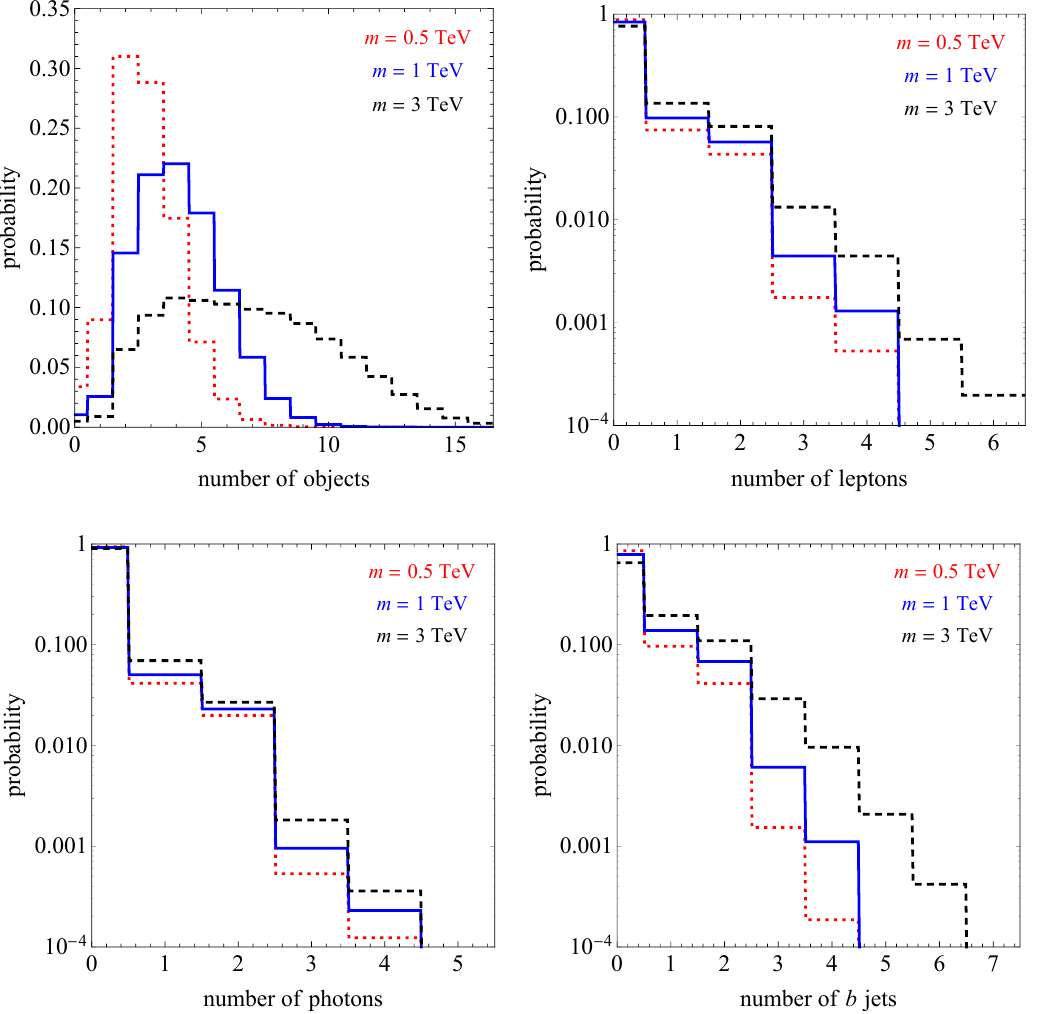
Figure 21 . For M 5 = 10 TeV, k = 1 GeV, and KK gravitons with mass 0.5 TeV (dotted red), 1 TeV (solid blue) and 3 TeV (dashed black), distributions of the number of objects (including jets, leptons and photons) with p T > 50 GeV (top-left), leptons with p T > 20 GeV (top-right), photons with p T > 20 GeV (bottom-left) and b jets with p T > 50 GeV (bottom-right). In all cases, only objects with j (cid:17) j < 2 : 5 are counted. Typical isolation and identi(cid:12)cation e(cid:14)ciencies have been